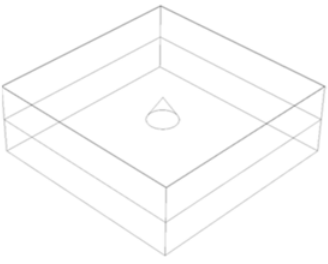
Figure 13. Perspective view of 3D model of experiment sample with non-visible defect.